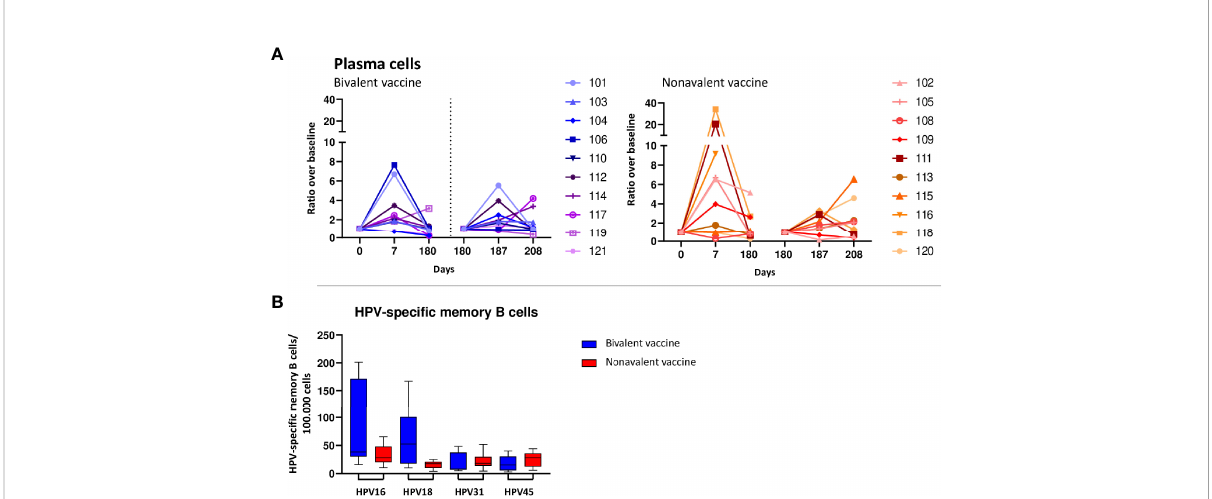
FIGURE 4 B-cell responses. (A) Increases in numbers of plasma cells upon bivalent (purple-blue) and nonavalent (orange-red) vaccination at day 0, 7, 180, 187 and 208 post vaccinations presented as ratio in numbers of cells compared to baseline numbers (cells/ m L blood) per participant, presented per vaccine cohort indicated. Participant identi fi cation by color is indicated on the right. At day 180, participants received the third HPV vaccination, therefore, this day served as a new ‘ baseline ’ moment to normalize the cell numbers from day 181 and 183, 1 and 3 days post third vaccination respectively. The dotted vertical line split the results post 1 st and 3th vaccination. (B) Numbers of HPV16/18/31/45 speci fi c memory B cells at day 208, 28 days post third vaccination. Puri fi ed B-cells have been stimulated polyclonally for 5 days and subsequently numbers of HPV-type speci fi c numbers of memory B-cells have been measured by ELISPOT assay in which plates have been coated with HPV-type speci fi c virus like particles